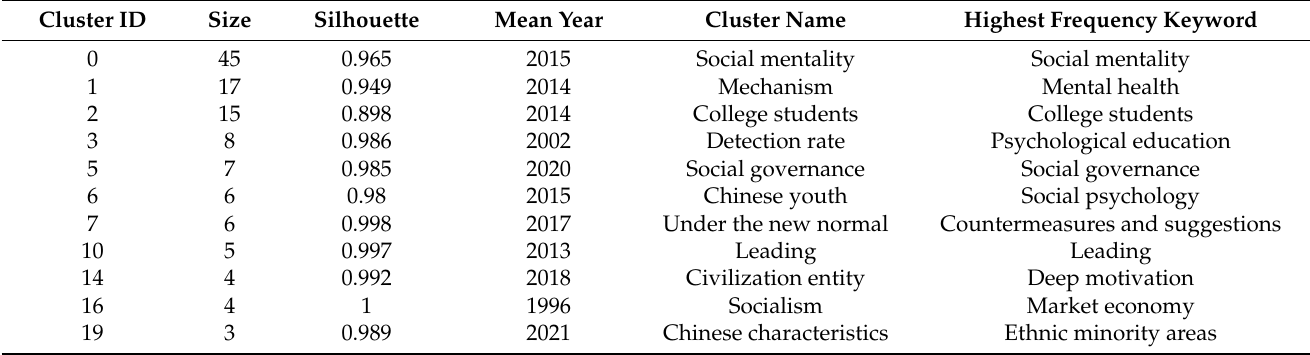
Table 2. Statistics of clusters on social mentality and health in the CNKI database before 1 April 2022 by keyword co-occurrence analysis via CiteSpace software (generated by the